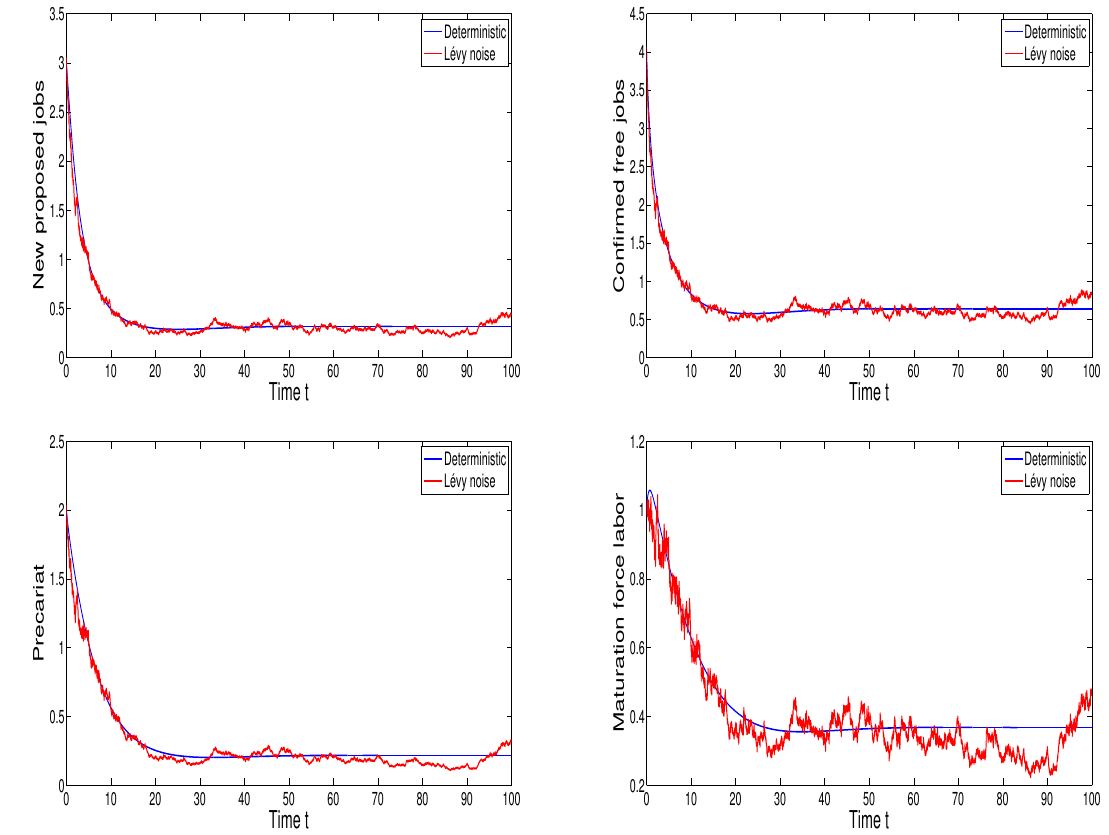
Figure 3. The behavior of free jobs and the labor